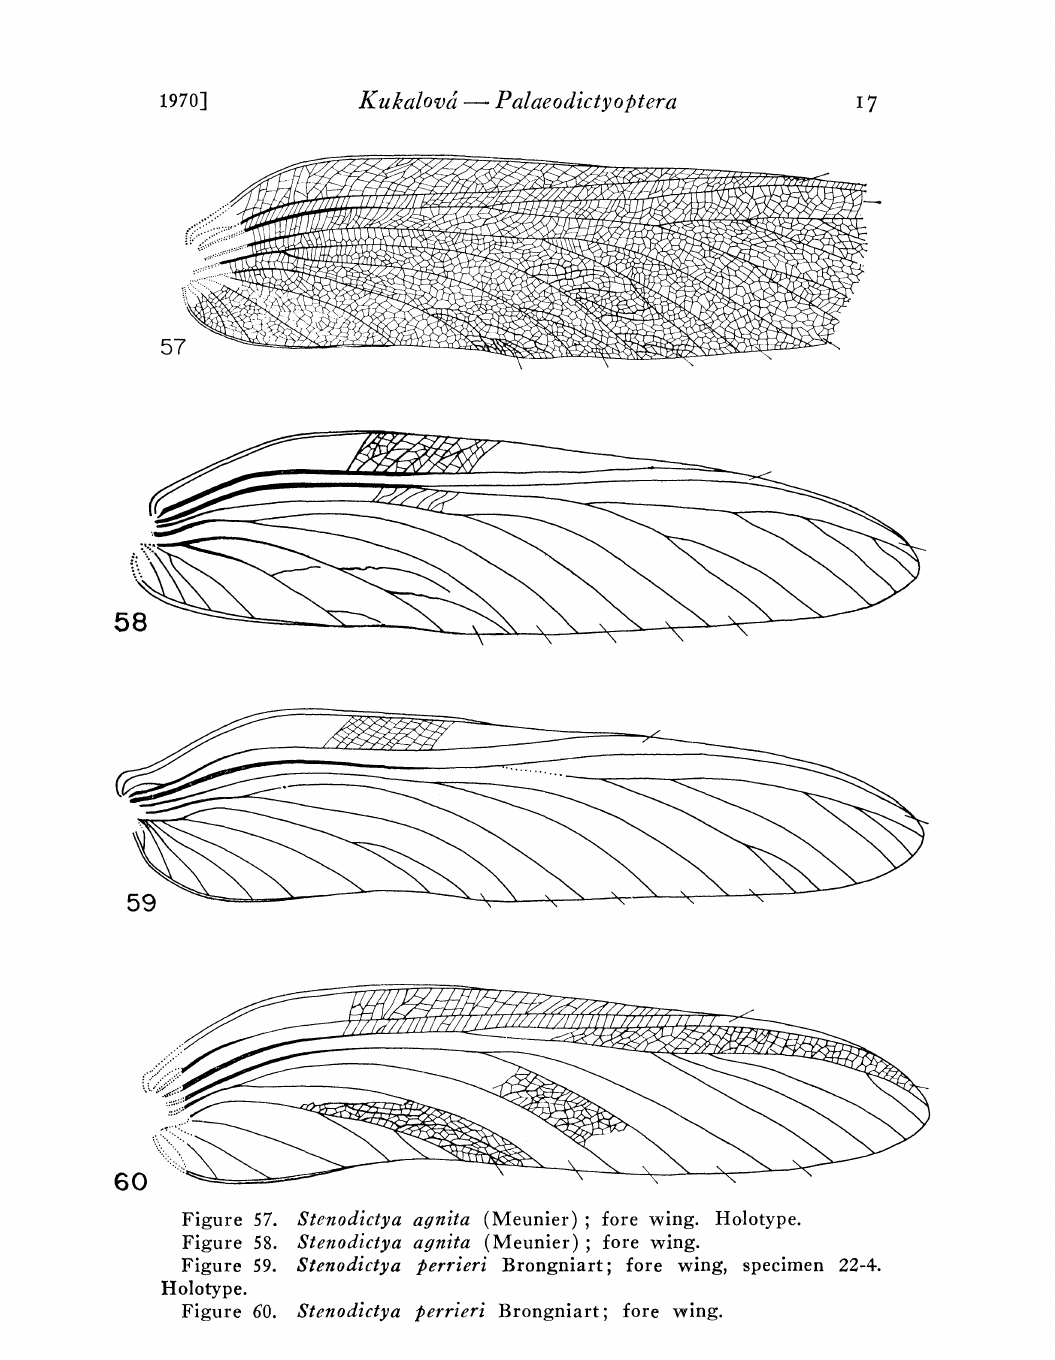
Figure 57. Stenodictya agnita (Meunier); fore wing. Ho,lotype. Figure 58. Stenodicty,a atlnita (Meunier); fore wing. Figure 59. Stenodictya perrieri Brongniart; fore wing, specimen 22-4. Holotype. Figure 60. Stenodictya perrieri Brongniart; fore